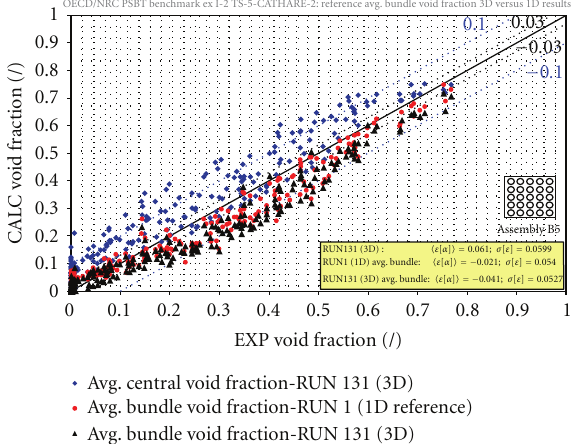
Figure 5: PSBT steady-state bundle (TS 5)—CATHARE2 3D and 1D models: central and bundle void fraction exp. versus calc., reference results.